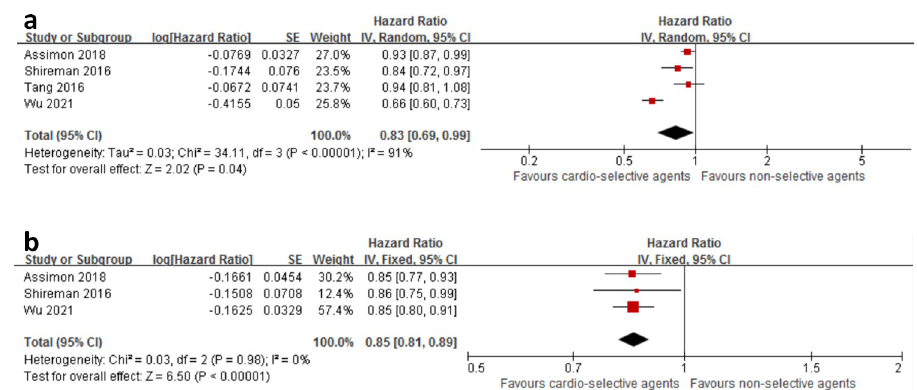
Fig 2. Forest plots for all-cause mortality and cardiovascular events. Cardio-selective β -blockers is associated with lower all-cause mortality (a) and cardiovascular events (b) in long-term dialysis patients when compared with non- selective β